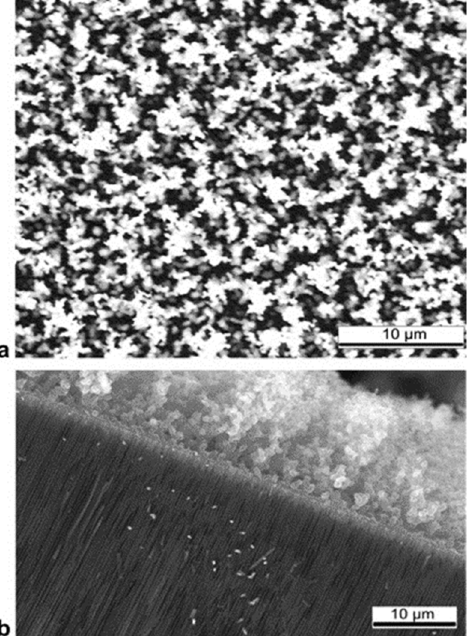
Figure 12. PAA/CNTs composite surface after non-catalytic synthesis of CNTs. ( a ) Top view and ( b ) side view where is identified a 20 μ m thick amorphous carbon overgrowth layer on top of the PAA surface. Reprinted with permission from Ref. [144]. Copyright © 2023 Elsevier Ltd. All rights re- served.